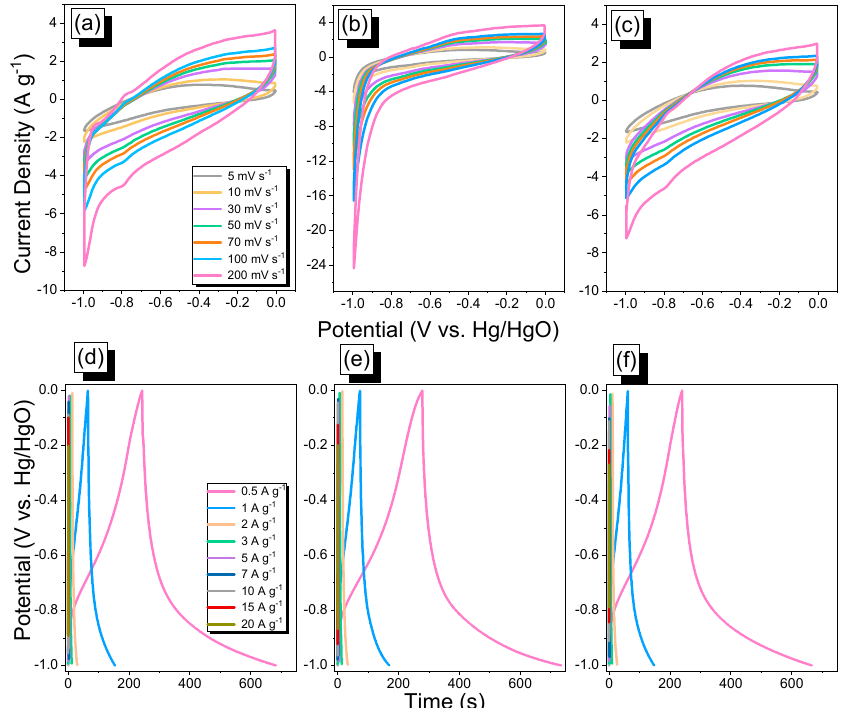
Figure 4. CV and GCD analyses of the TPA–BBT–CMP ( a , d ), Py–BBT–CMP ( b , e ), and TPE–BBT– CMP ( c , f ).